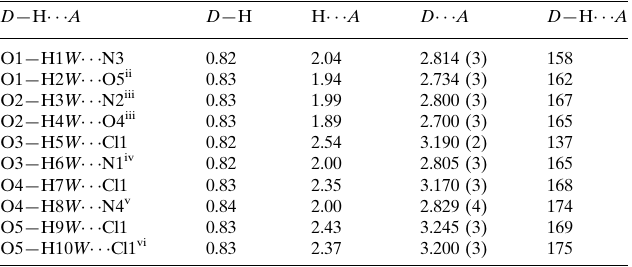
Hydrogen-bond geometry (A˚ , (cid:2)